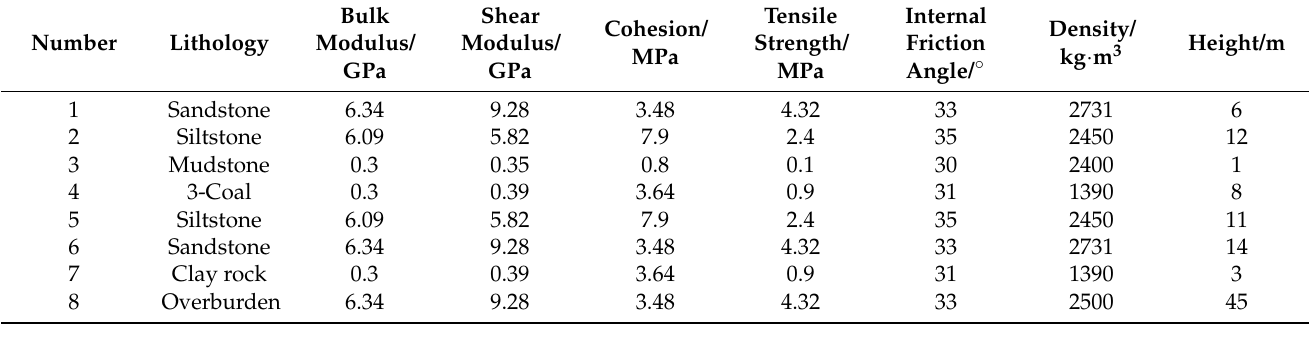
Table 1. Rock mechanical parameters.